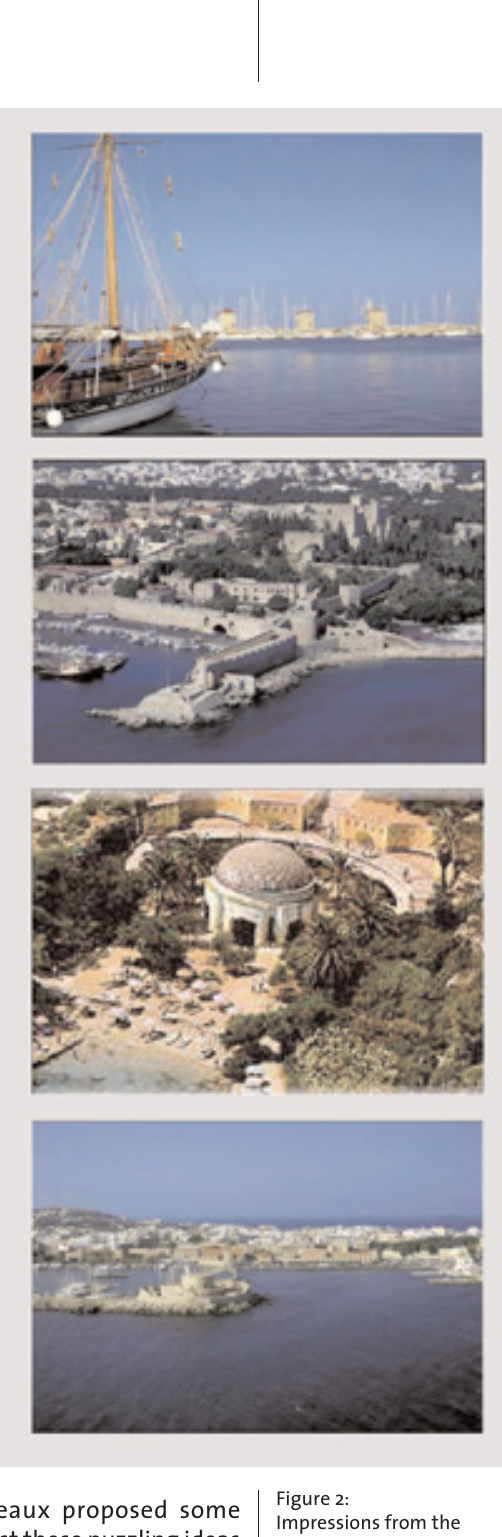
Figure 2: Impressions from the Island of Rhodes,